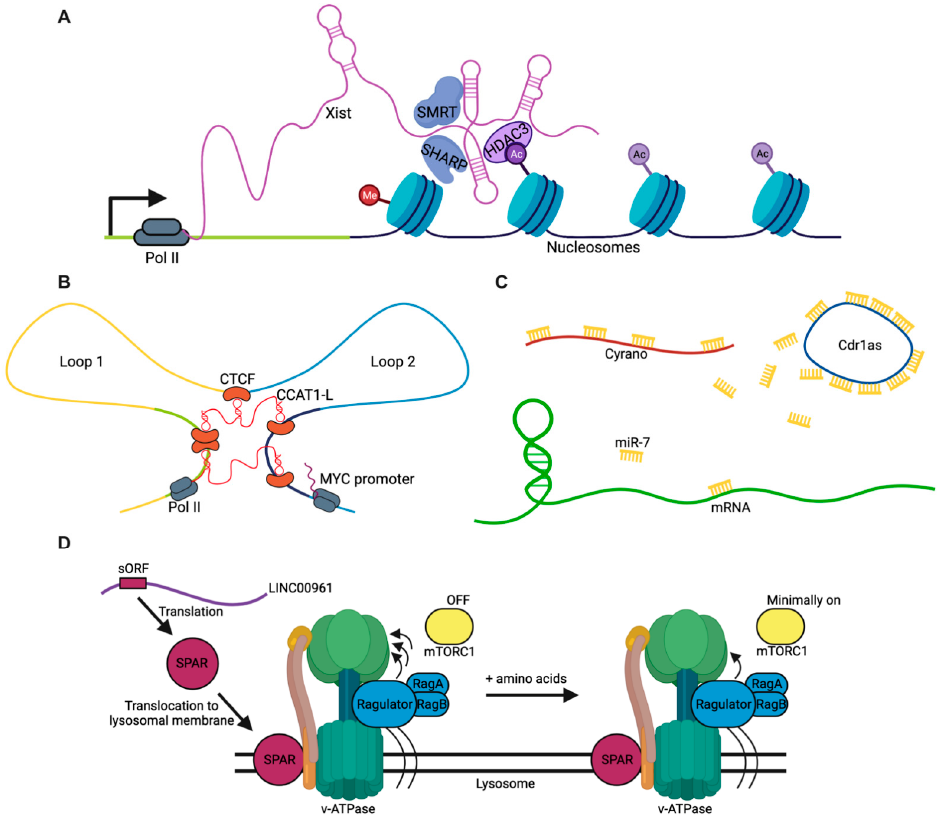
Figure 2. Mechanisms of lncRNAs. ( A ) lncRNAs can act as guides, such as Xist which recruits HDAC1-associated protein (SHARP), silencing the mediator for retinoid and thyroid hormone receptor (SMART), and HDAC3 to inactivate an X chromosome [48,49]. ( B ) lncRNAs can act as scaffolds, such as CCAT1-L, which accumulates in cis to regulate chromatin looping between enhancers and the MYC promoter [50]. ( C ) lncRNAs can act as sponges, such as in the ceRNA regulatory network where the lncRNA Cyrano triggers degradation of miR-7 and prevents it from repressing its target RNAs including the circRNA Cdr1as [51]. ( D ) Some previously annotated lncRNAs may encode peptides, such as LIN00961 whose small open reading frame (sORF) is translated into the small regulatory polypeptide of amino acid response (SPAR) that binds to lysosomal ATPase and prevents the dissociation of Ragulator upon amino acid stimulation resulting in minimal mTORC1 activation